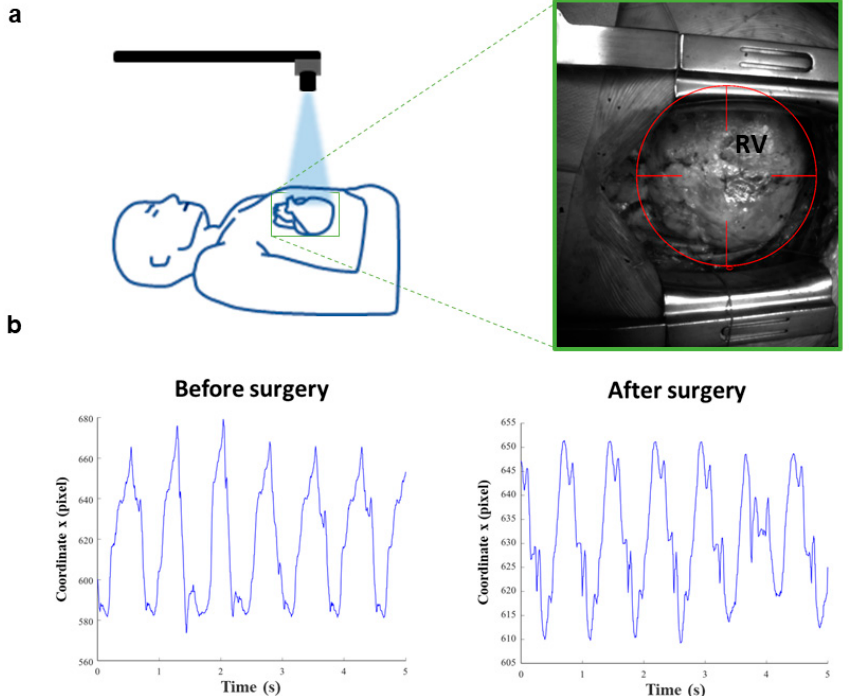
Figure 1. Vi.Ki.E. workflow and coordinates of a representative ToF patient. ( a ) Schematic represen- tation of the Vi.Ki.E. surgical setup (left). The green square surrounding the heart is magnified in the right panel displaying the virtual marker position on the right ventricle (RV) epicardium. ( b ) The x coordinates extracted from a 5 s video recording before and after surgery phases.